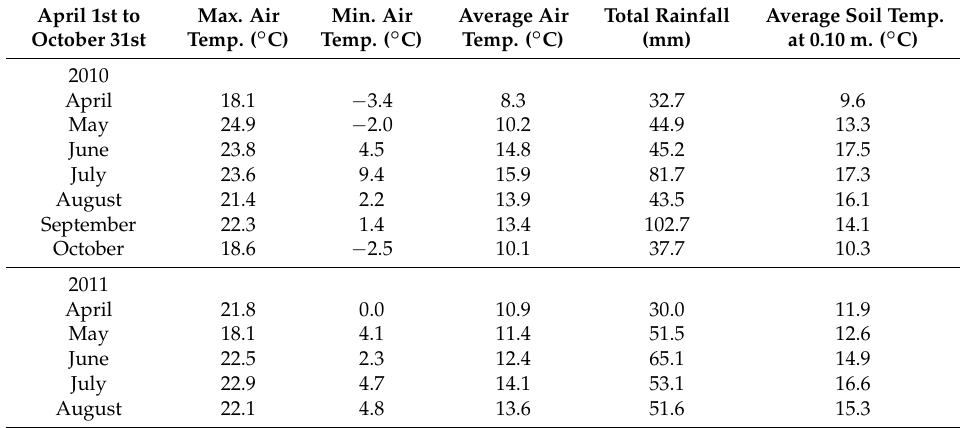
Table 3. Meteorological data in the growing seasons between April 1st and October 31st in 2010 & 2011.